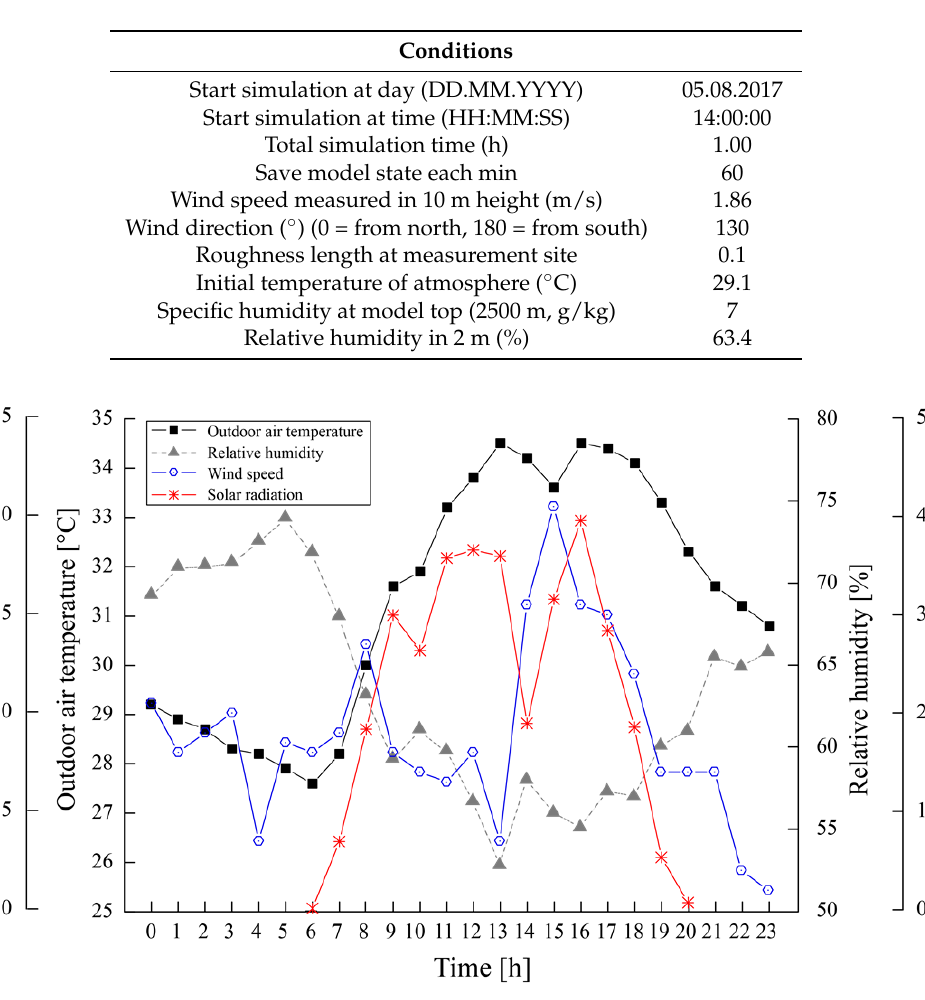
Figure 6. Weather conditions during micrometeorological modeling simulation.